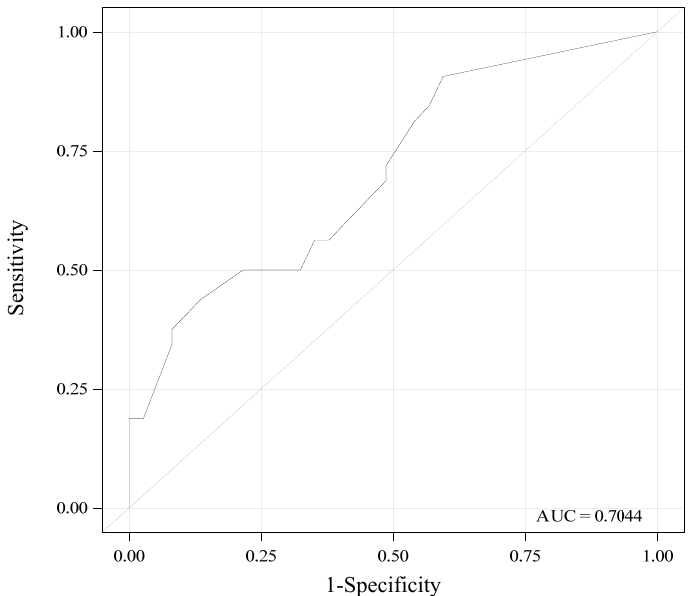
Figure 4. Area under the receiving operating curve (ROC) showing the performance of the Simple Evaluation of Food Intake ® assisted by photography (SEFI ® -AP) at day 3 for diagnosis of malnutrition (n = 69). SEFI ® -AP is expressed as the mean of lunch and dinner. Malnutrition was diagnosed according to the Global Leadership Initiative on Malnutrition (GLIM) criteria: body mass index < 22 or weight loss at 1 month ≥ 5% or weight loss at 6 months ≥ 10% or lower calf circumference (<31 cm). AUC = 0.70 [95% confidence interval, (CI) 0.58–0.83] indicates a correct diagnostic performance. Sensitivity, specificity, positive and negative predictive values [95% CI] of the SEFI ® -AP < 7 at day 3 for diagnosis of malnutrition were: 56% [39–73], 65% [49–80], 58% [41–75] and 63% [48–78], respectively.